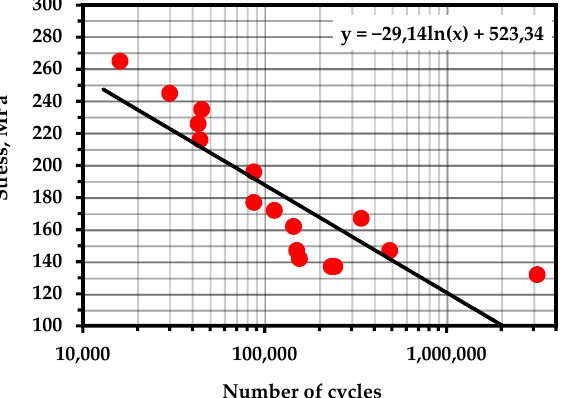
Figure A15. S–N Curve—Al 7075 alloy (Temperature—293 K; frequency—60 Hz) [107].